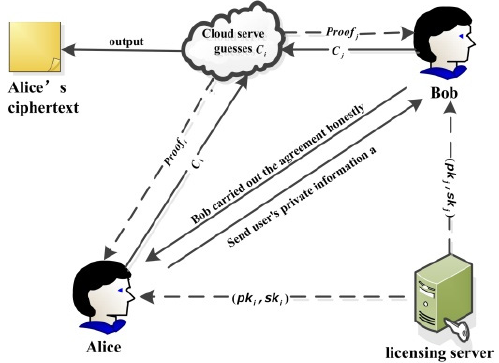
Figure 1. The process of the cloud server stealing Alice’s plaintext.